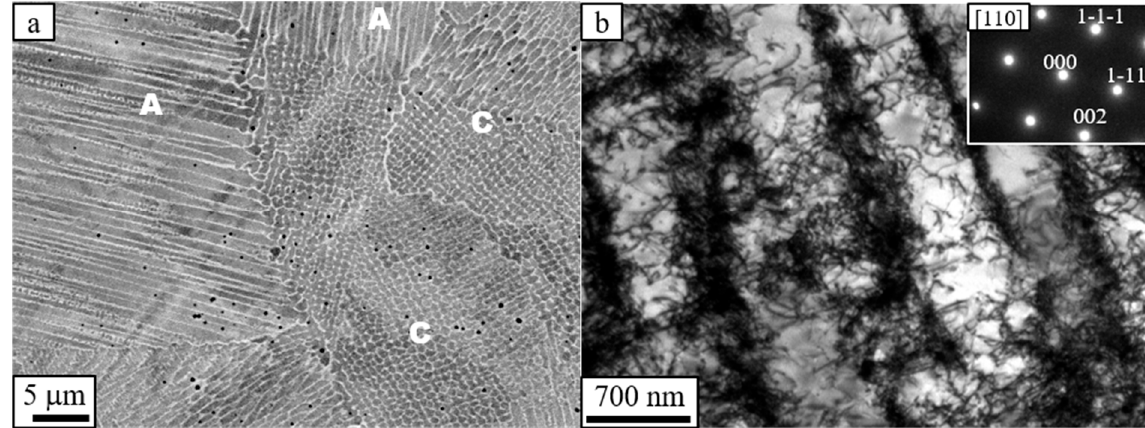
Figure 1. Microstructure of as-printed L-PBF-Inconel 718. ( a ) SEM electron backscatter image showing cellular and columnar subgrains. The labels A and C indicate columnar and cellular subgrains, respectively. ( b ) TEM bright field image showing entangled high-density dislocations along the columnar subgrain boundaries. The inset is a selected area diffraction (SAD) pattern.